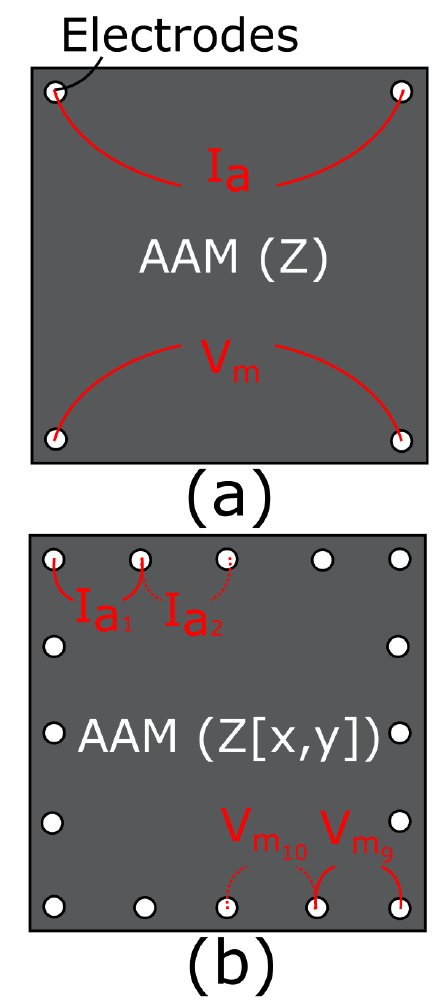
Figure 2. Configuration of electrodes in test samples: ( a ) VDP method for measuring impedance, Z of a single 4-probe cell, ( b ) serial tomographic measurement of 16-probe cell, V a is applied over a single electrode pair (1 shown), while V m is measured over all other 15 pairs (9 shown). This is repeated for every combination to give impedance array, Z [ x , y ] where x is applying pair and y is measuring